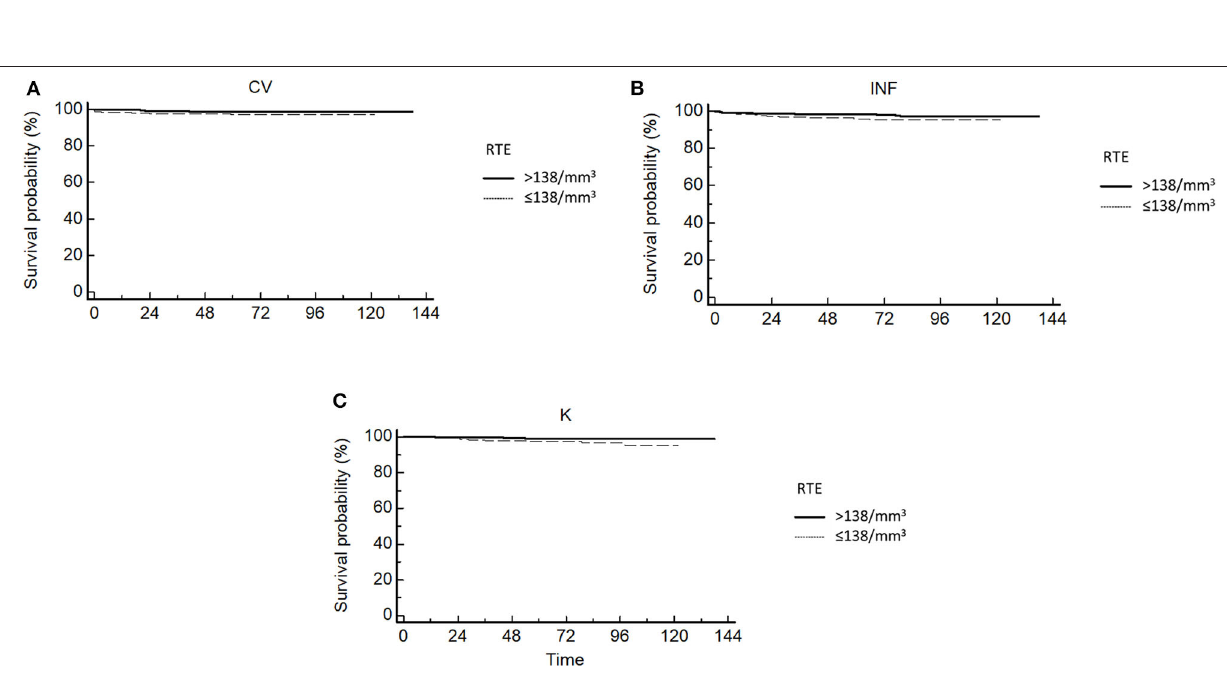
FIGURE 2 | (A) Kaplan-Meier cardiovascular death in transplantation-free survival curves for patients according to quartiles of RTE. (B) Kaplan-Meier infection-related death in transplantation-free survival curves for patients according to quartiles of RTE. (C) Kaplan-Meier cancer death in transplantation-free survival curves for patients according to quartiles of